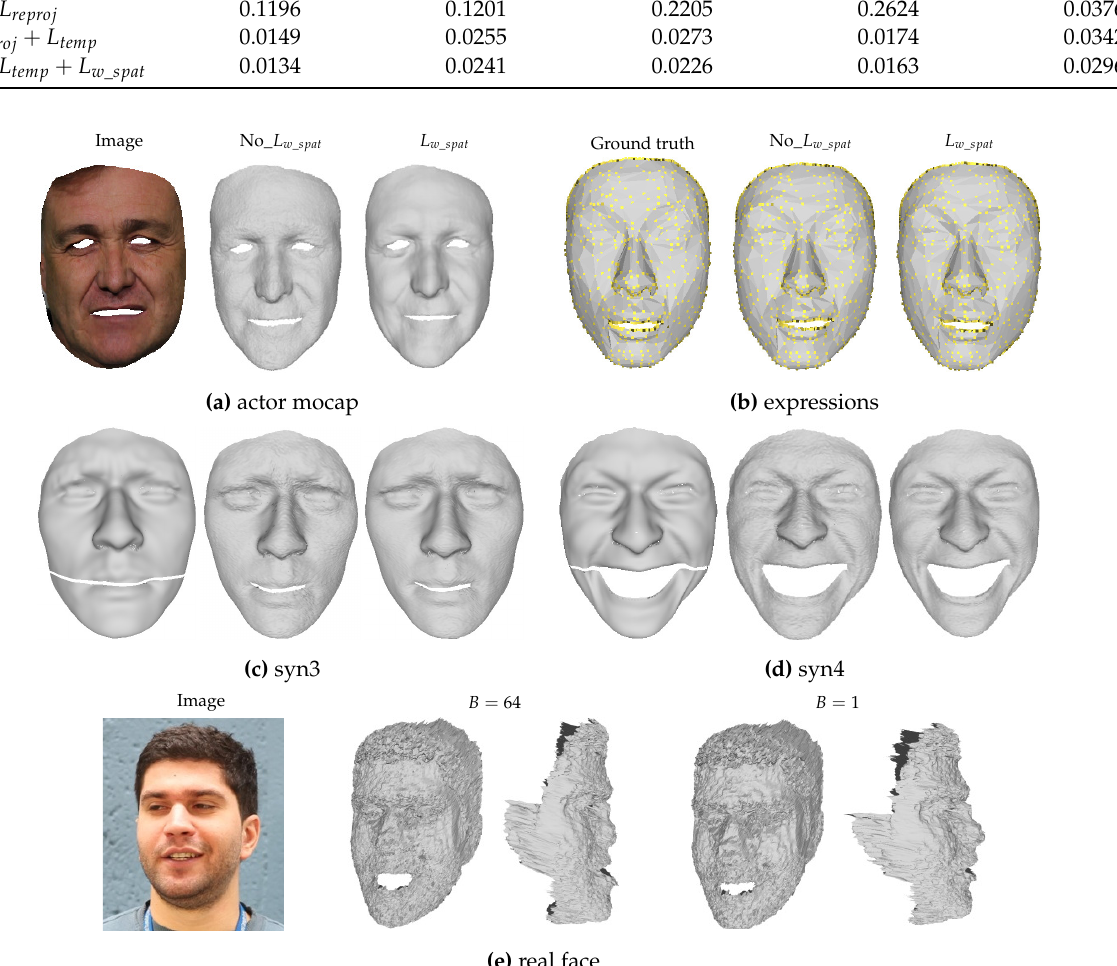
Figure 6. Visualized ablation and contrast experiment results. From left to right, genuine pictures, and 3D reconstruction without and with the weighted spatial constraint are displayed in ( a – d ). ( a – d ) depict the ablation experiment results of actor mocap, expressions, syn3, and syn4, respectively; the yellow points in ( b ) are the reconstructed point clouds, whereas the black points are the inverted 3D points. From left to right, ( e ) displays the true images of the real face dataset and the front and side views of the reconstruction results when the number of neurons in the middlemost layer of the shape-estimation network is B = 1 and B =